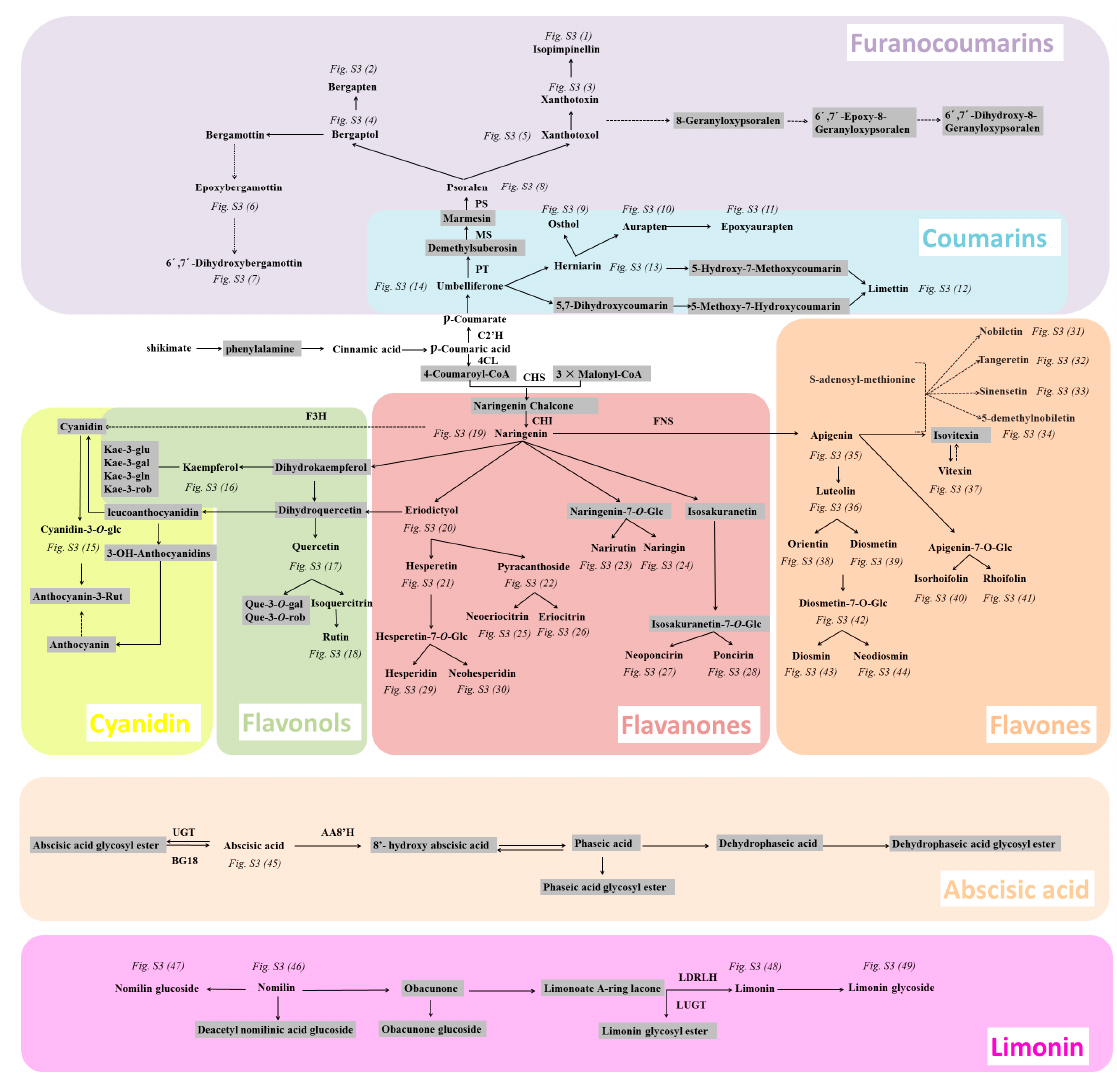
Figure 7. Comparison of the biosynthesis and accumulation of metabolites between Citrus samples.